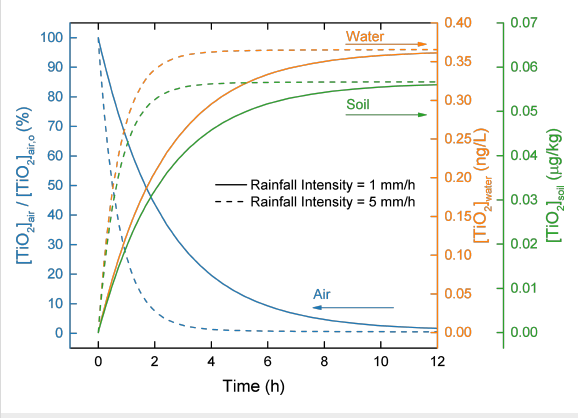
Figure 11: Effect of rain scavenging on TiO 2 concentration in air, water, and soil in Los Angeles as a function of rainfall intensity (1–5 mm h − 1 ). All ENM release rates are terminated at the start of a long rain event, which was taken to last for 12 h. Regional geograph- ical parameters are reported in Supporting Information File 1, Table